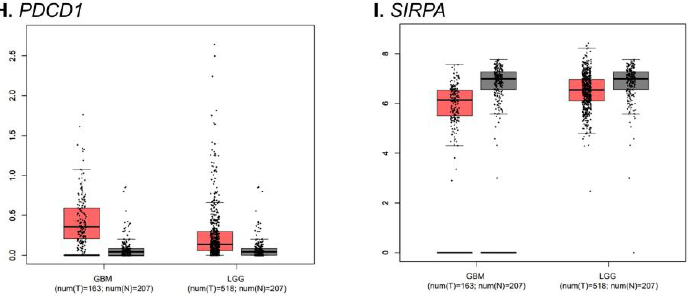
Figure 7. RNA transcript expression of CD274 , PDCD1LG2 , HAVCR2, PDCD1, SIRPA genes in GBM and LGG tissues and healthy control. Panel ( A ) summarizes differences in expression of analysed genes, it presents median Z-score. The lower TPM of each of the analysed genes is connected with more favorable overall survival when comparing gliomas (including LGG and GBM) vs. healthy tissue ( C , E , G ). The greatest benefit of low transcription is illustrated by Kaplan-Meier curve for CD274 ( C ). Z-score of PDCD1 gene in comparison between GBM and control showed significant difference ( D ). Additionaly, TIM-3 coding gene is characterised by a higher number of transcripts in both LGG and GBM ( F ). No significant differences were noted for CD274, PDCD1 and SIRPA ( B , H , I ). The data described above were downloaded from The Cancer Genome Atlas (TCGA) database and Genotype-Tissue Expression (GTEx). The asterisk symbol (*) in the figure indicates a statistically significant difference between two compared groups. * p < 0.05 HAVCR2 - Hepatitis A virus cellular receptor 2, TIM-3 gene; CD274 - PD-L1 coding gene; PDCD1LG2 -PD-L2 coding gene; PDCD1 -PD-1 coding gene; SIRPA - SIRPalpha coding gene; TPM- transcript per million; LGG-low grade glioma (WHO grading I and II); GBM-glioblastoma (WHO grading